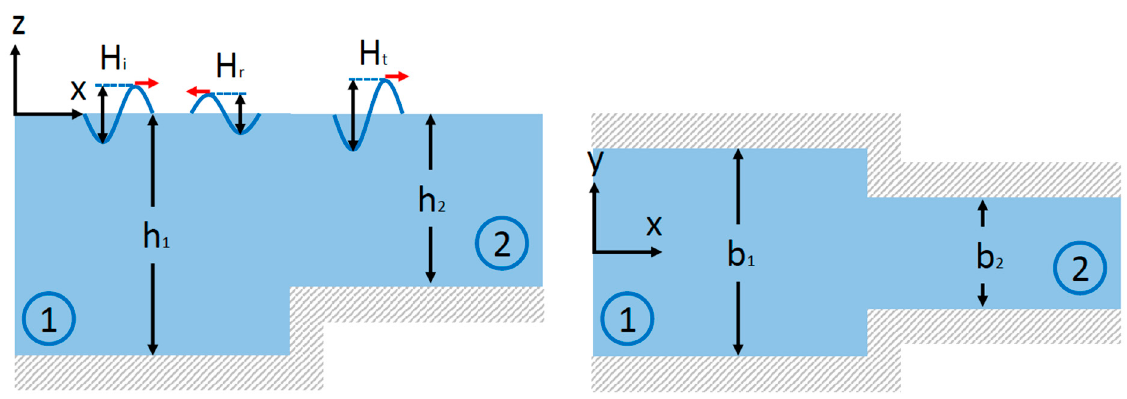
Figure 2. Cross-sectional and top view of an abrupt cross-sectional change. The wave heights H i , H r , and H t indicate the incident, reflected, and transmitted wave heights, respectively. The red arrows show the wave propagation direction. The numbers 1 and 2 indicate different locations with respective widths b and depths h .